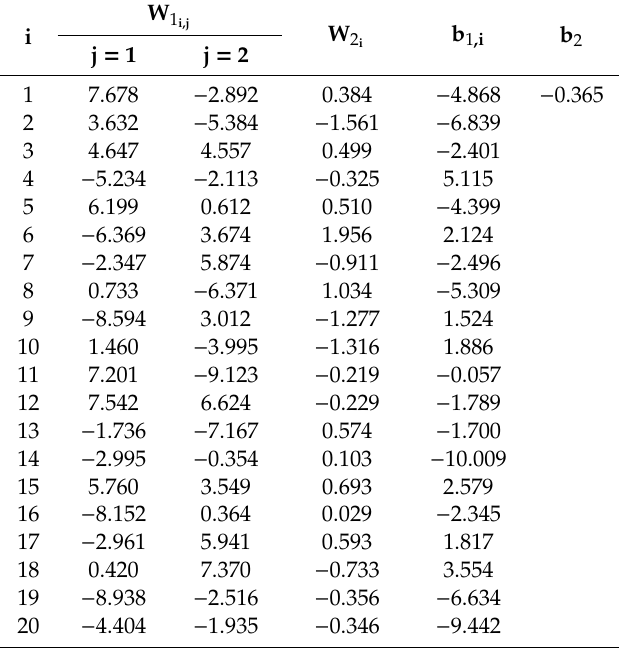
Table A3. Constants for estimating the normalized AV n in Equation